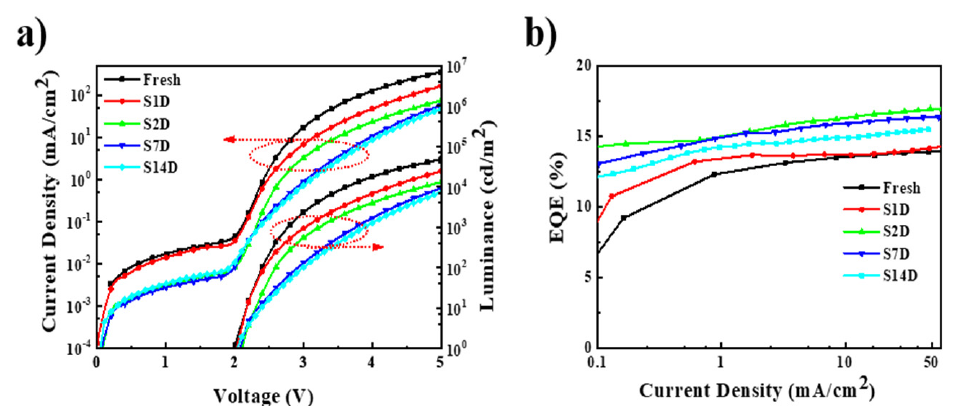
Figure 5. ( a ) The current density–voltage–luminance (J–V–L) characteristics of the QLEDs after storage from 0 to 14 days; ( b ) external quantum efficiency–current density (EQE–J) characteristics of the QLEDs after storage from 0 to 14